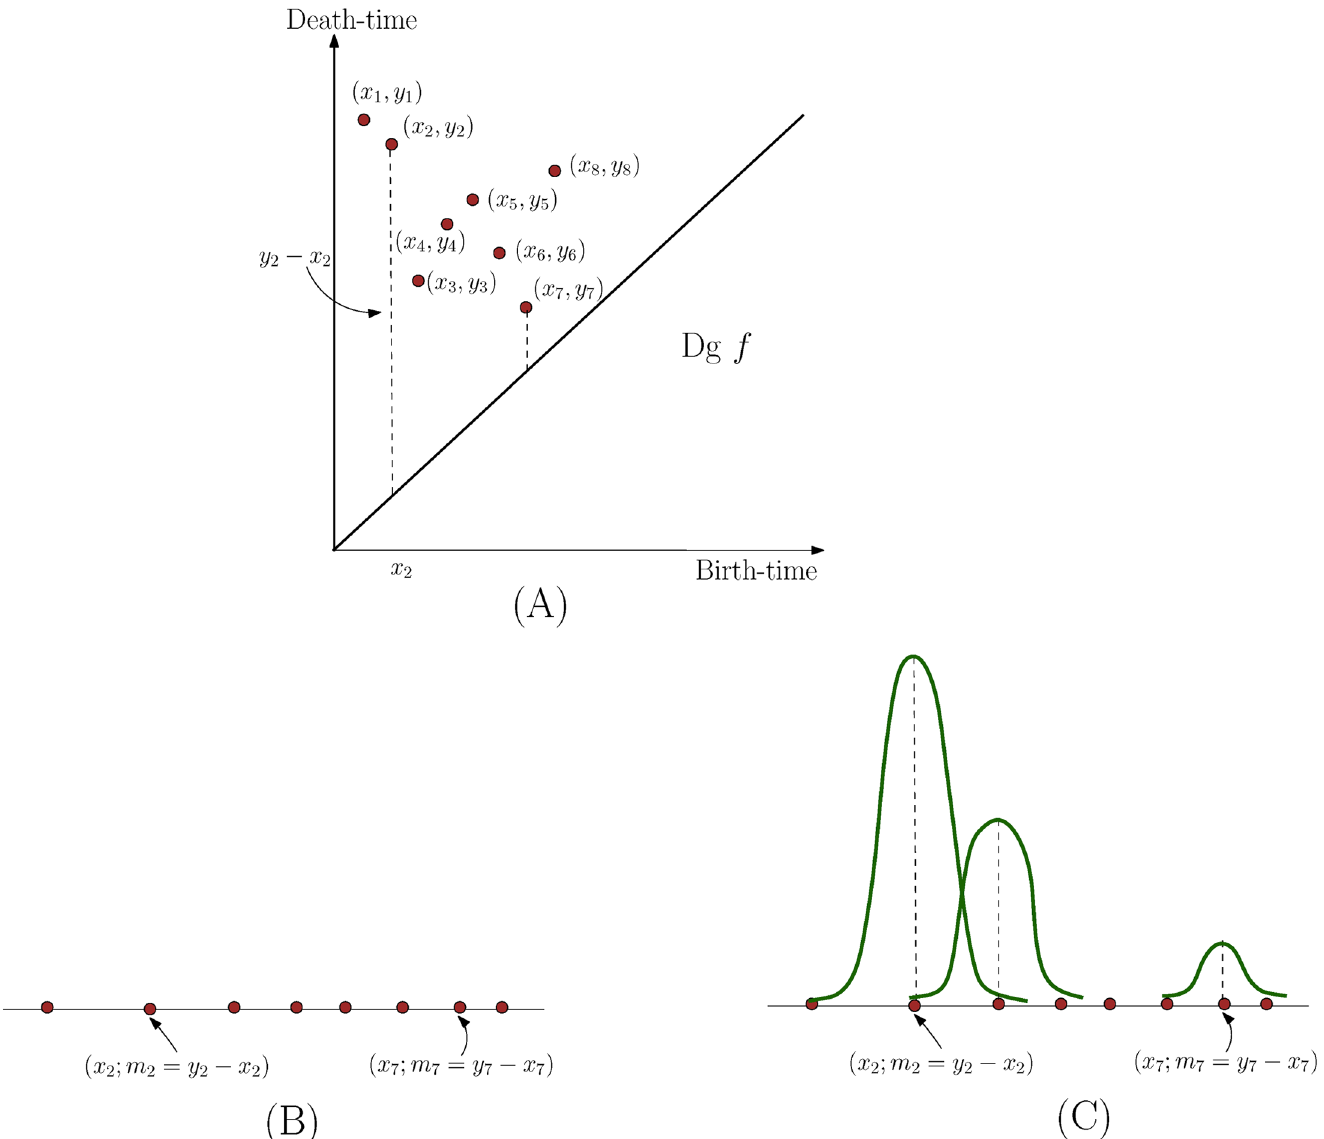
Fig 4. Converting persistence diagram to a 1D density function. We convert persistent points in the persistent diagram Dgf in (A) into a set of weightedpoints in the line as shown in (B). We then put a Gaussian function m i (cid:1) K t ( x i , (cid:1) ) at each point x Note that a point with lower persistence(such as ( x 7 , y 7 − x 7 )) has less contribution to the final density function ρ D